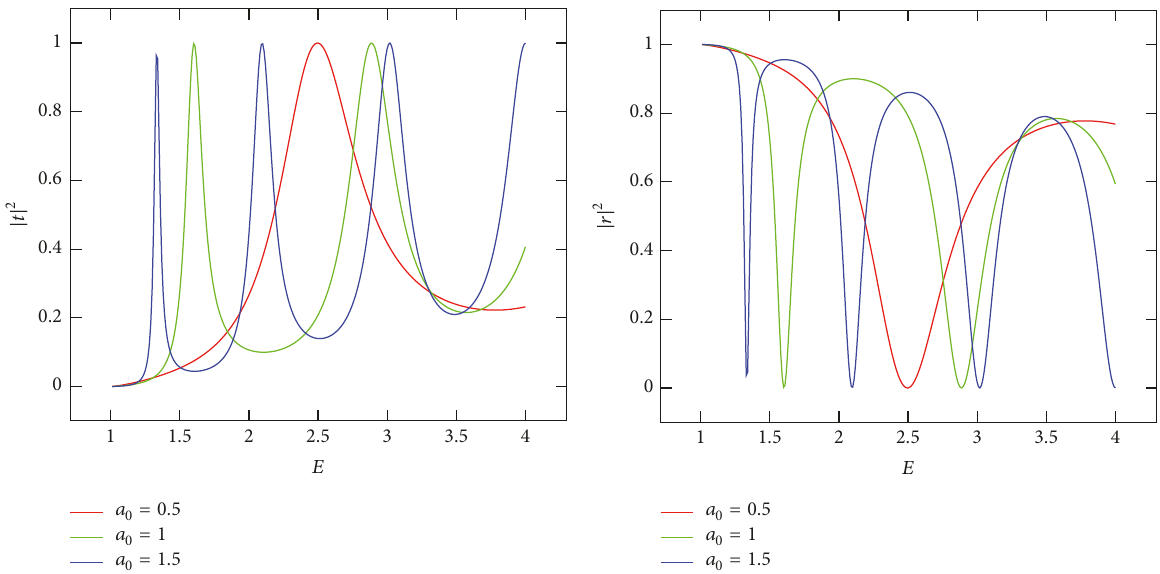
Figure 4: Effects of different values of 𝑎 0 on the